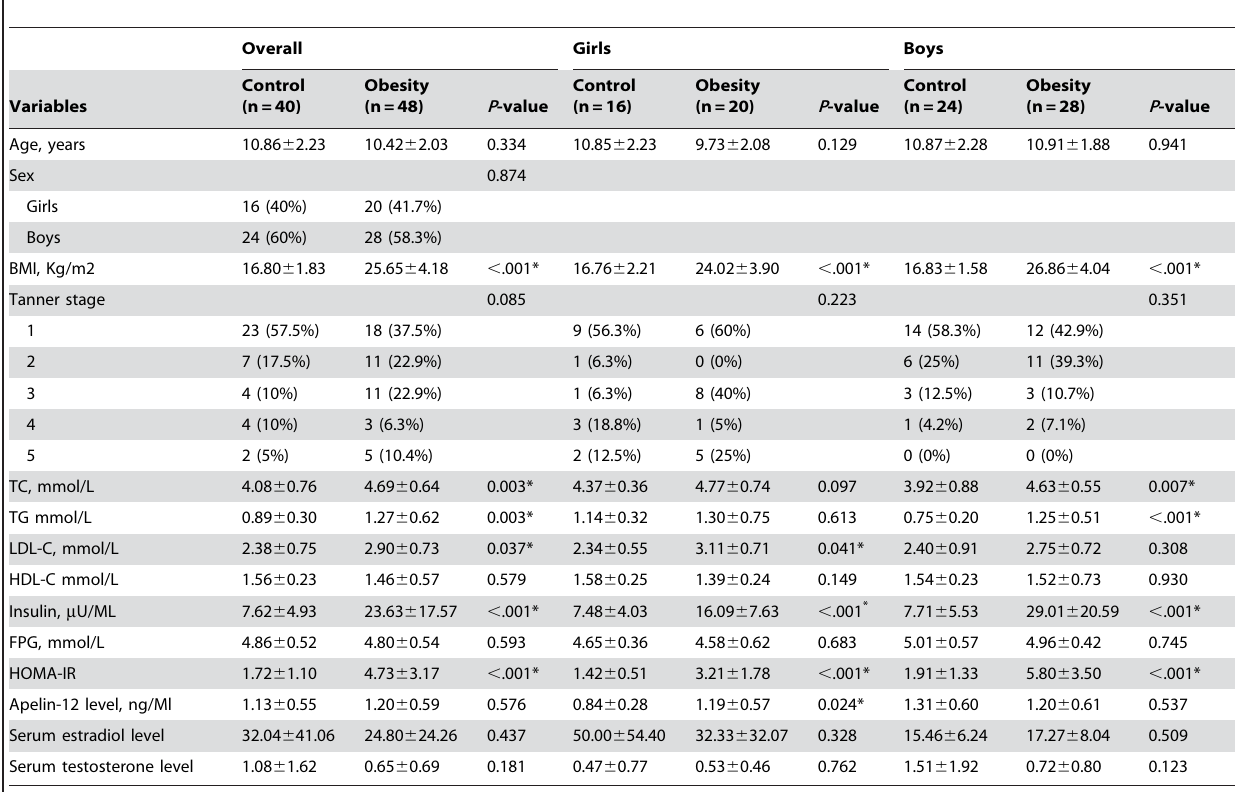
Table 1. Demographics and clinical characteristics of all subjects by obese and control groups and boys and girls